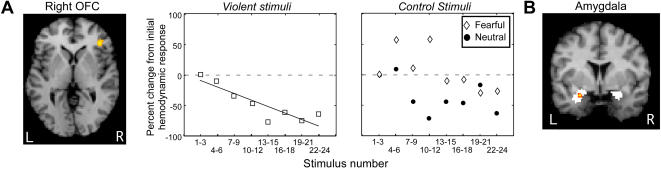
Exposure to violent stimuli diminishes activation of a frontolimbic regulatory circuit.Presented are the significant voxels in right ltOFC for the response attenuation regression analysis, in which the violent condition is compared against the controls. Average hemodynamic responses (HDRs) were extracted on a per-trial basis from this cluster during all three film conditions; these responses were averaged across subjects based on condition type and exposure number, then averaged together into consecutive bins of three. Presented are the maximum signal changes of each binned HDR, expressed as a fraction of the first bin magnitude. The violent clips induced a continuous response attenuation trend that was not present during exposure to the fearful or neutral clips (r2
violence = 0.79, p = 0.003; r2
fearful = 0.41, p = 0.09; r2
neutral = 0.30, p = 0.16). It is important to note that certain areas such as the amygdala were active during the individual conditions alone, or even combined, but that these areas did not show a differential activation between the violent and control conditions. In attention-related areas, all three conditions produced nearly identical attenuation trends; see Fig S2. (B) Psychophysiological interaction analysis identified left amygdala voxels in which functional connectivity with right ltOFC decreased with each exposure to the violent stimuli (p<0.05, mixed-effects t-test). [White underlay is the amygdala ROI, identified using anatomical automatic labeling (AAL).]